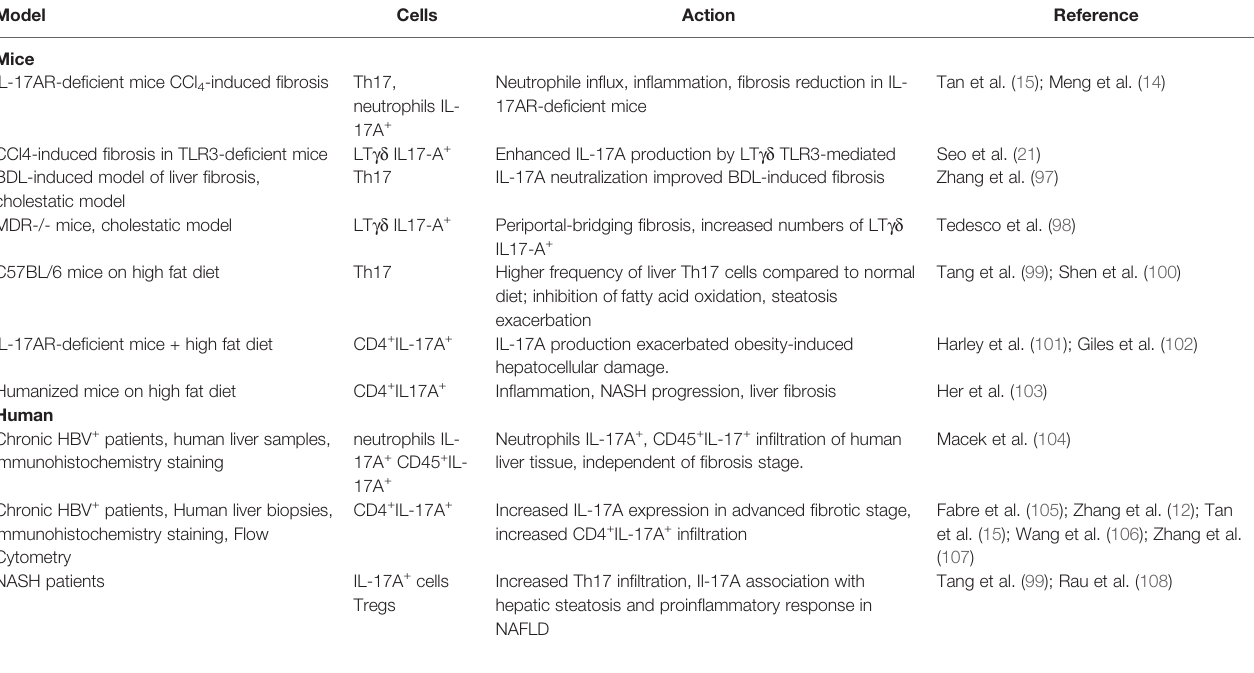
TABLE 2 | IL-17A in chronic liver injury.